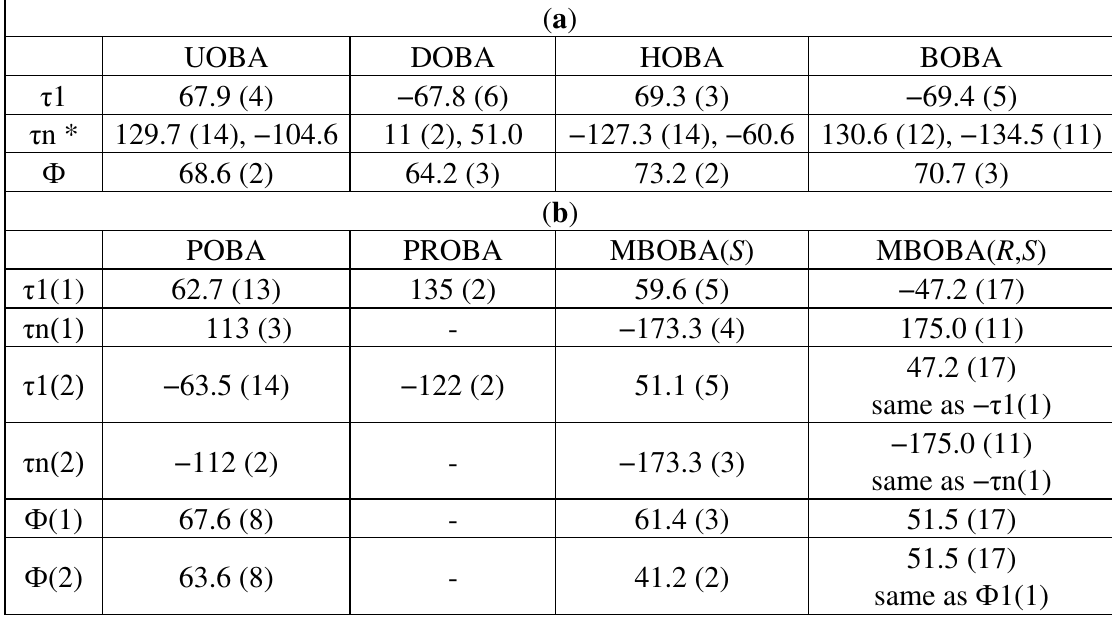
Table 5. ( a ) Torsion angles τ 1 , τ n in degree describing the placement of the alkoxy group of some 4-benzoic acids: τ 1(O3-C7-C8-C9), τ n represents the allyl terminal group ending with the double bonded terminal C-atom (partial occupancy: *). Twist angle Ф in degree is defined between phenyl plane and the alkyl plane excluding the double bonded terminal C-